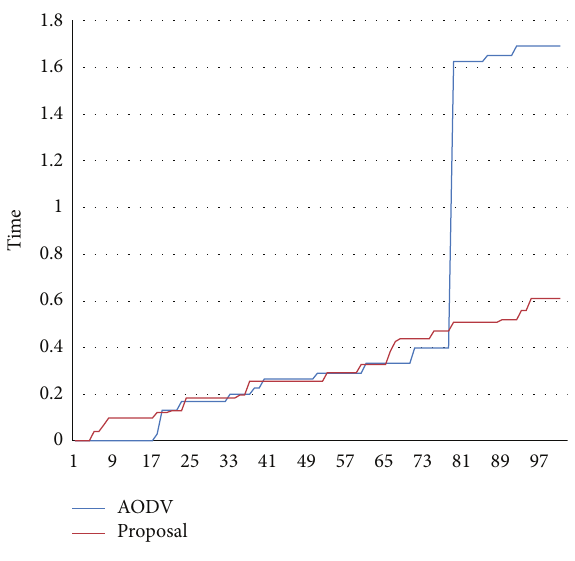
Figure 9: Comparison of route discovery time.